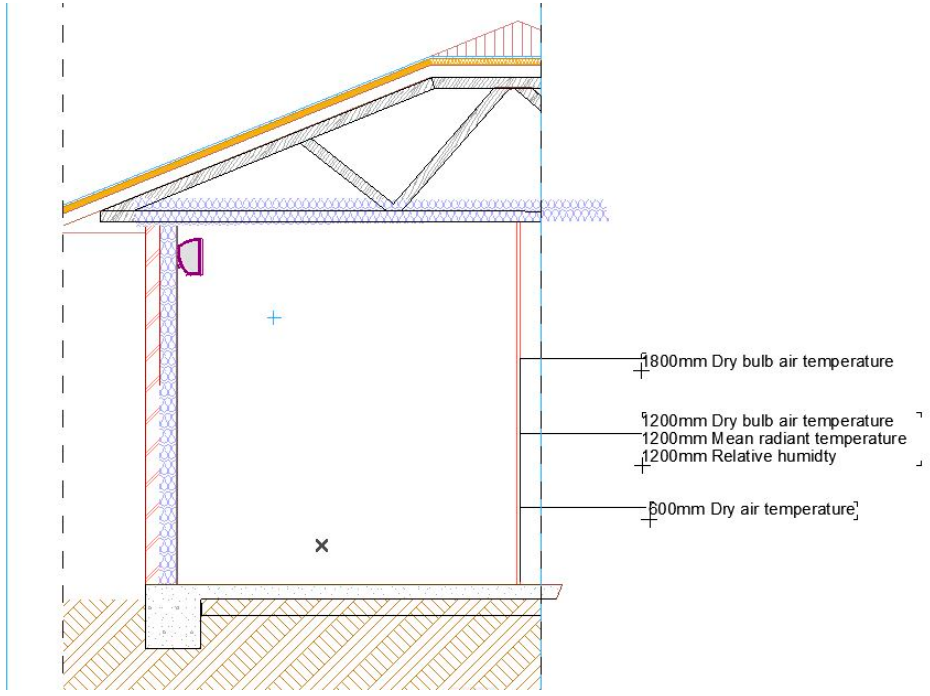
Figure 5. Architectural section of test building.